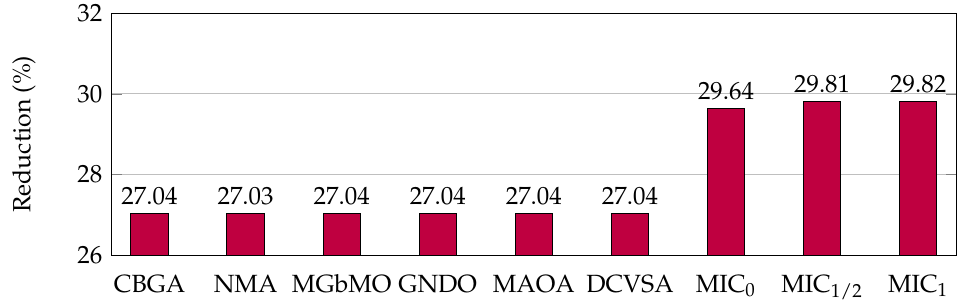
Figure 5. Reduction percentage for each solution methodology with respect to the benchmark case in the IEEE 33-bus network.